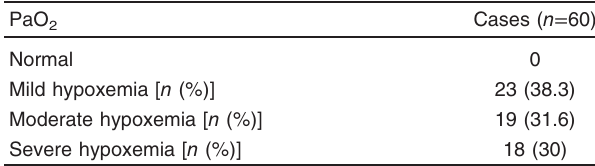
Table 8 Illustrate the degree of hypoxemia among cases